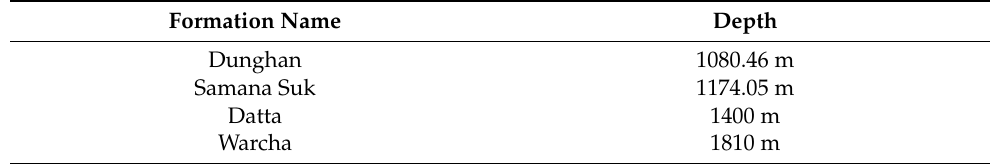
Table 6. Marked zones of interest encountered in Tola-01